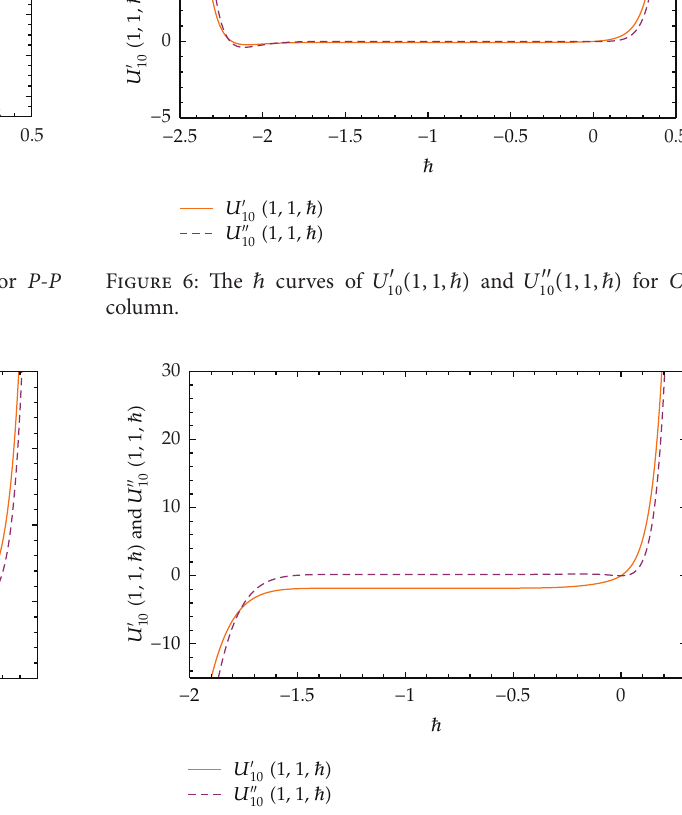
Figure 5: The ℎ curves of 𝑈 󸀠 10 (1,1, ℎ) and 𝑈 󸀠󸀠 10 (1,1, ℎ) for C - P column.